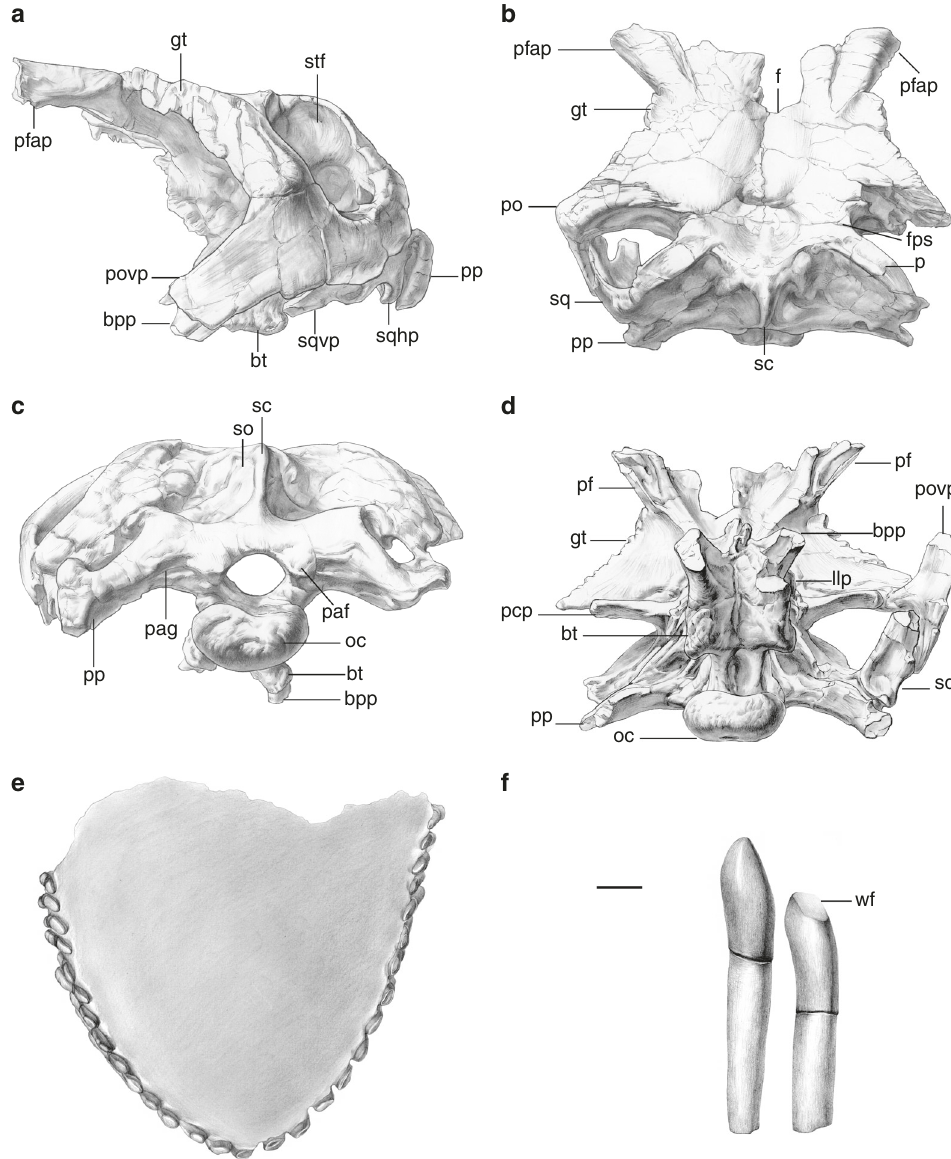
Fig. 1 Cranial material of Lingwulong shenqi . Braincase in: left lateral ( a ), dorsal ( b ), occipital ( c ), and ventral ( d ) views. Dentary teeth in occlusal view ( e ). The 5th and 6th left dentary tooth crowns in labial view ( f ). Abbreviations: bpp, basipterygoid process; bt, basal tubera; f, frontal; fps, frontoparietal suture; gt, grooves and tubercles; pf, prefrontal; llp, ‘ leaf ’ -like process; oc, occipital condyle; p, parietal; pcp, capitate process; paf, proatlantal facet; pag, proatlantal groove; pfap, prefrontal anterior process; po, postorbital; povp, postorbital ventral process; pp, paroccipital process; sc, sagittal crest; so, supraoccipital; sq, squamosal; sqhp, squamosal hook-like process; sqvp, squamosal ventral process; stf, supratemporal fenestra; wf, wear facet. Scale bars = 20 mm for a – e and 10 mm for